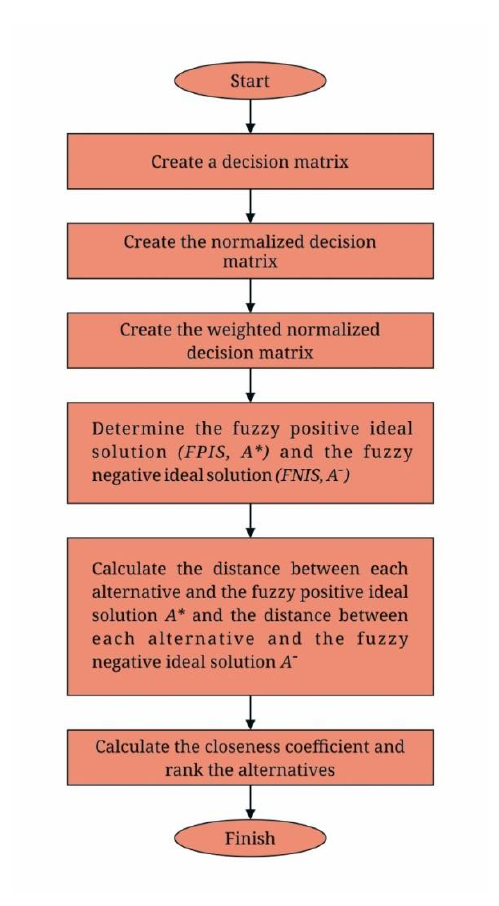
Figure 2. Hierarchical structure for the evaluation